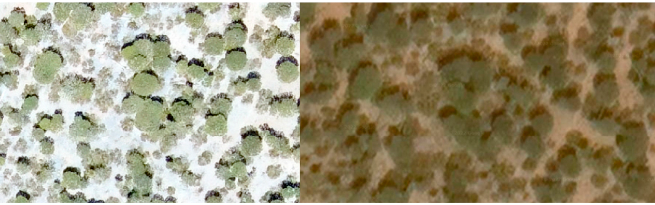
Figure 12. Comparison of UAV orthophoto ( left ) and Google orthophoto ( right ) in (a section of) Firmihin.